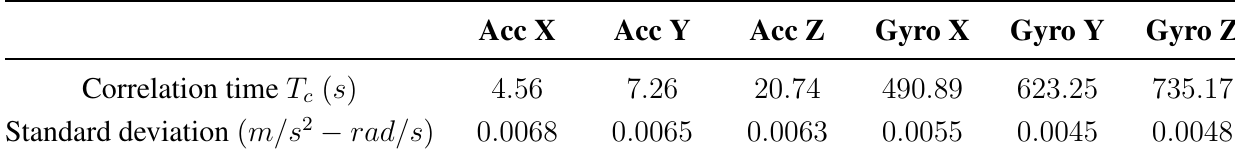
Table 5. Identified correlation time, ( T c ) , for the bias instability (B) and standard deviation for each inertial sensor of the 3DM-GX3